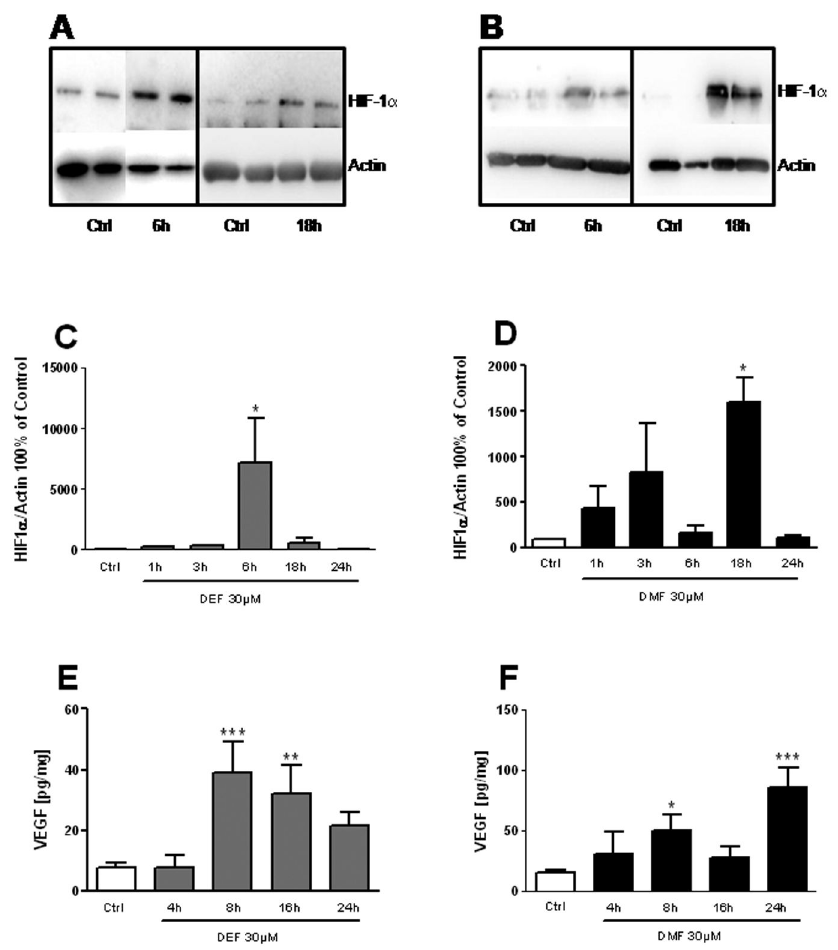
Figure 2. FAEs induce HIF-1α accumulation and VEGF release in astrocytes. Wild type astrocytes were treated with 30µM DEF (A, C, E) or 30µM DMF (B, D, E) for the indicated times. HIF-1α level was measured by Western-Blot (A, B, C, D). VEGF in the supernatant was quantified by ELISA (E, F); *p<0,05; ***p<0,001; significantly different from corresponding control. Values are mean+/-SEM of n=3 independent